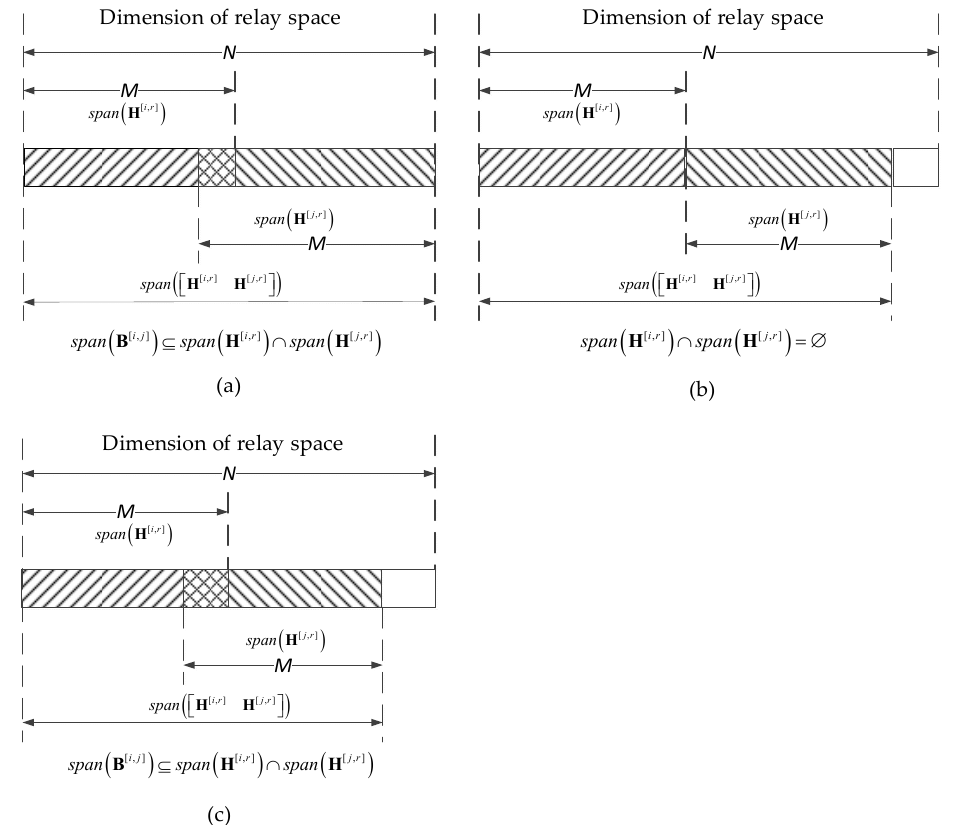
Figure 3. Distribution change of equivalent channel spanned space of nodes. ( a ) Traditional SSA ( N < 2 M ), ( b ) SSA ( N ≥ 2 M ), ( c ) SSA after space compression ( N ≥ 2 M ).